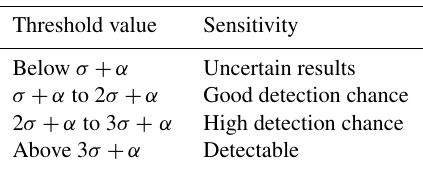
Table 1. Detection thresholds that were adopted to investigate the CRNS sensitivity to irrigation